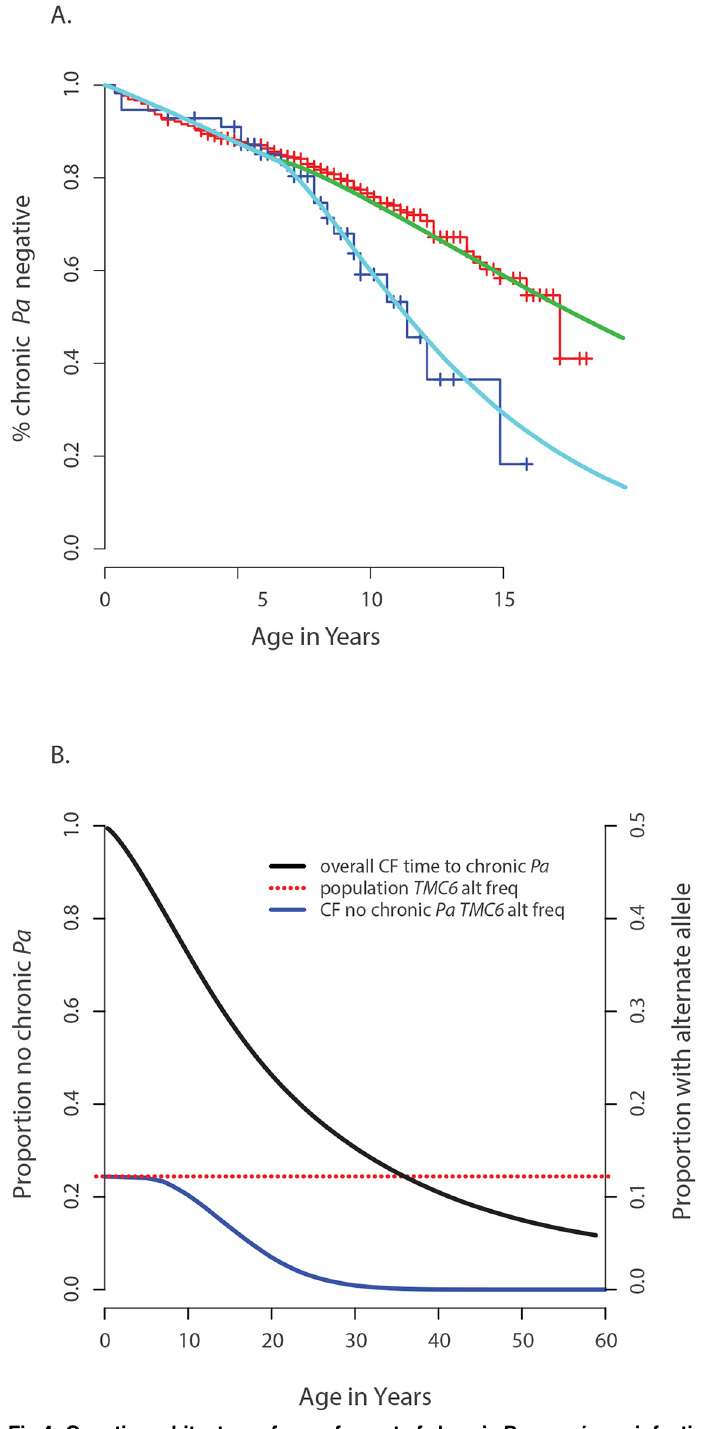
Fig 4. Genetic architecture of age-of-onset of chronic P . aeruginosa infection and TMC6 rs34712518. ( A ) Observed age of onset for children with at least one rs34712518 allele (blue) and without (red), compared to Weibull distribution models for age of onset among children with at least one rs34712518 allele (light blue) and without (green). ( B ) Blue: The probability of carrying at least one rs34712518 allele given age of onset is beyond age X (i.e. one does not have chronic P . aeruginosa infection by age X) based on the event probabilities for each carrier state shown in (A). The probability of being a carrier declines markedly